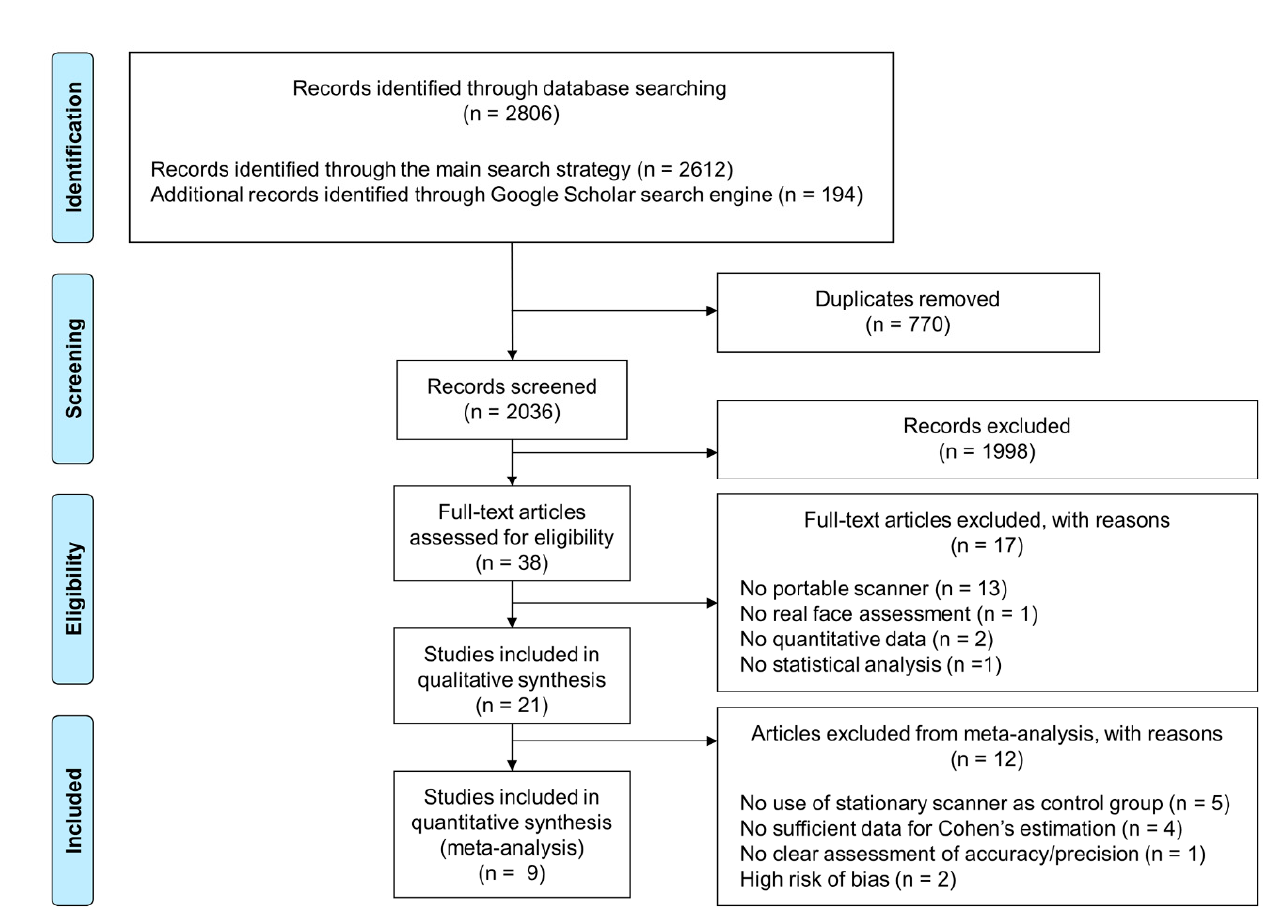
Figure 1. PRISMA flow diagram summarizing the literature search and selection process.